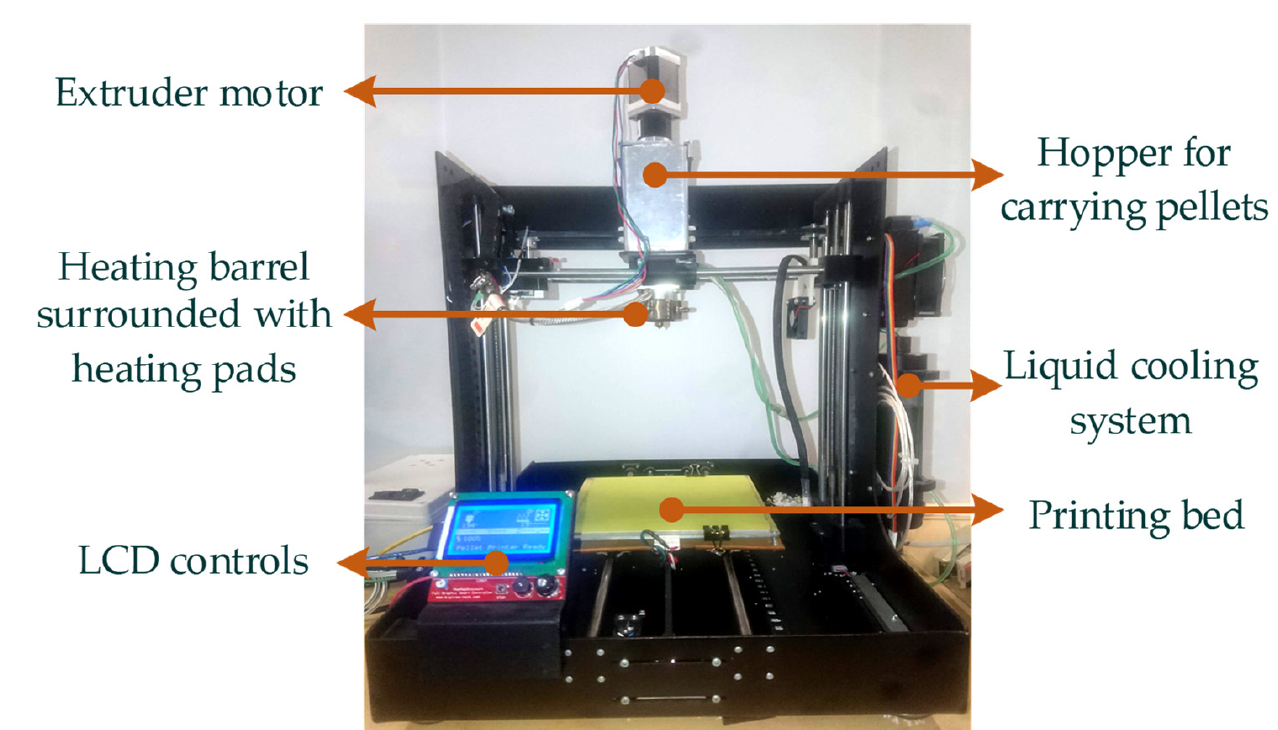
Figure 1. In-house built pellet 3D printer [23]. The CAD drawings of ASTM D638 Type IV [25] was designed on Solidworks version 2018 and saved in standard tessellation language (stl.) format. The dimensions are shown in Figure 2. The “stl” files were sliced into layers using a slicing software (Slic3er). The parameters for slicing are given in Table